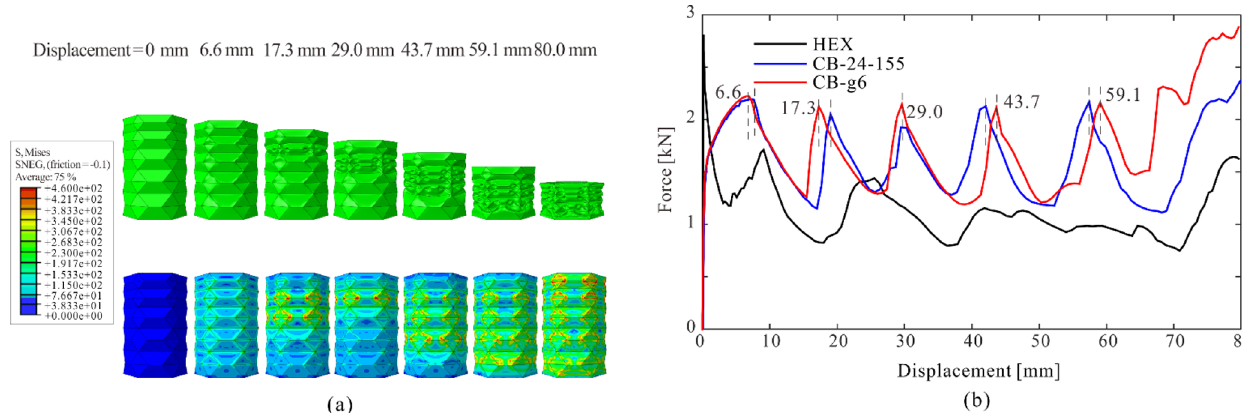
Figure 8. Effect of graded layer height. (a) The deformation process of CB-g6; (b) force versus displacement curves of HEX, CB-24-155, and CB-g6.